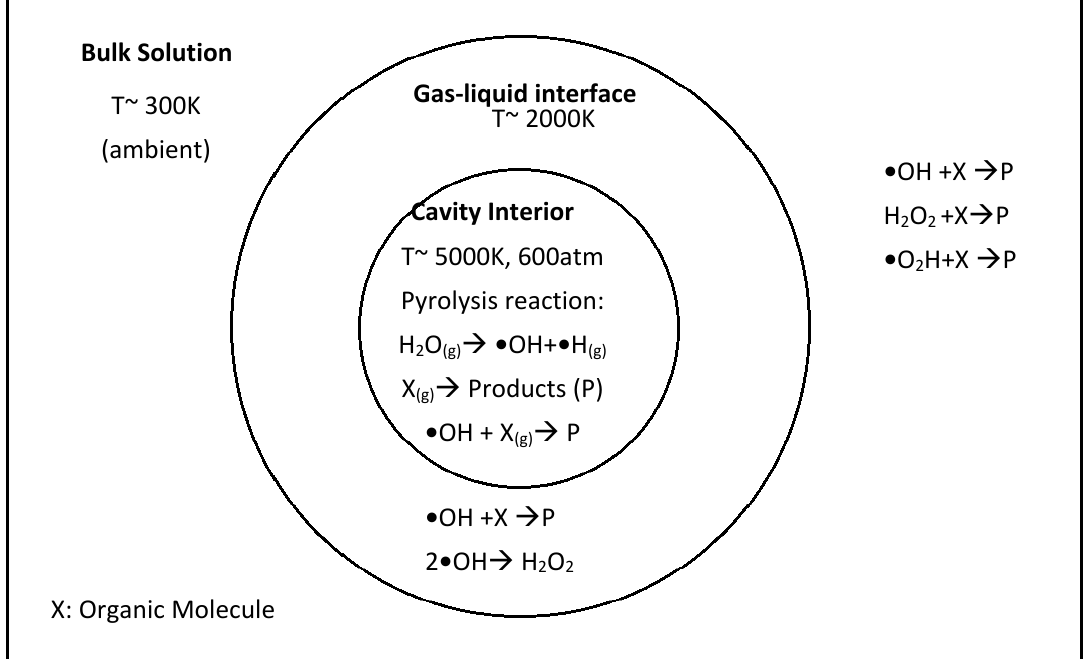
Figure 1. Main reaction sites in homogenous sonochemistry [18].